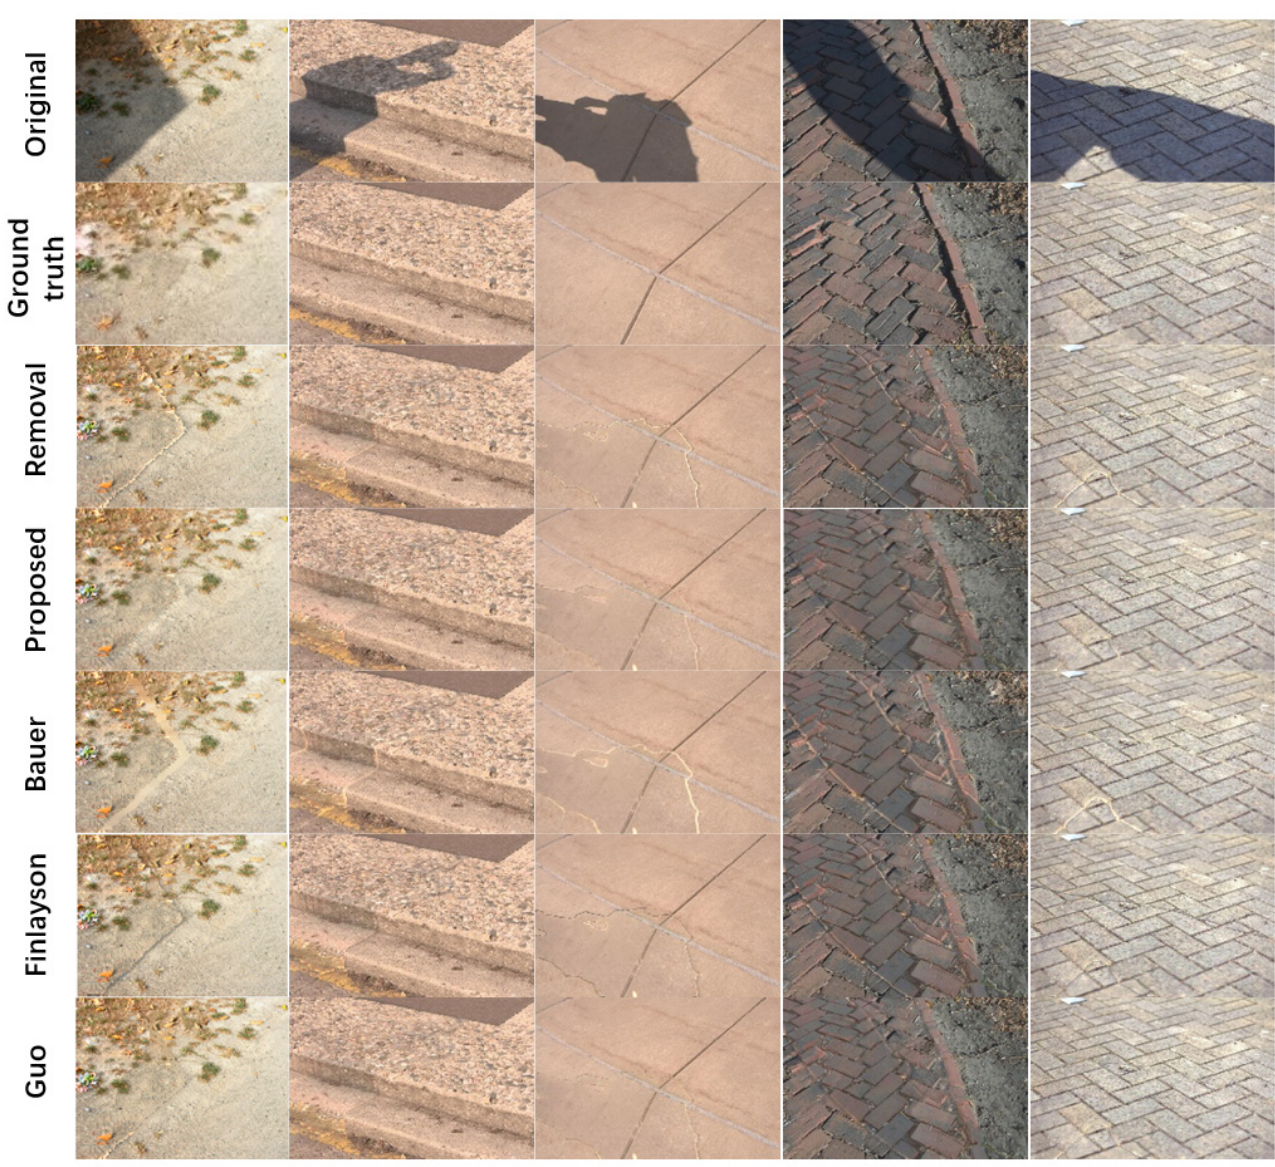
Figure 19. Comparison among the different penumbra removal methods. The first row is the original images; the second row is the ground truth; the third row is the results without penumbra removal; the fourth row is the results of the proposed method; the fifth row is the results of Bauer’s method; the sixth row is the results of Finlayson’s method; and the seventh row is the results of Guo’s method.